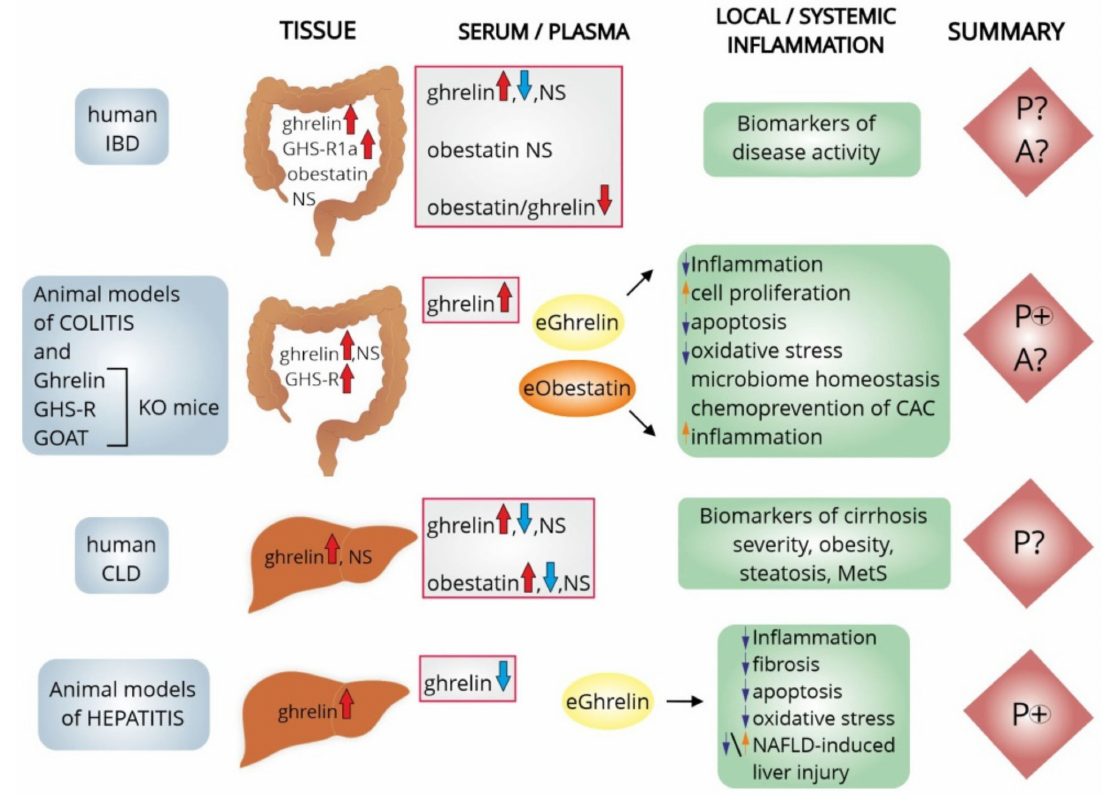
Figure 2. Potential role of the ghrelin system in the local and systemic inflammatory process of the colon and liver in humans and in various animal models of colitis and hepatitis. Protective, anti-inflammatory, and healing effects are the main effects of exogenous ghrelin and obestatin in animal models of colitis, however, there are some experimental data showing the proinflamma- tory effects of ghrelin in mice models of colitis. In chronic inflammatory liver diseases of various etiologies, ghrelin also exhibits hepatoprotective (anti-inflammatory, antioxidant and anti-fibrotic) effects. The protective effects of ghrelin have also been shown in various animal models of NAFLD, although enhancement of lipogenesis and lipid accumulation in the liver of mice after adminis- tration of exogenous ghrelin has also been described. The protective role of the ghrelin system in colitis/hepatitis-associated carcinogenesis is still unclear and requires continued research. [ ↑ / ↓